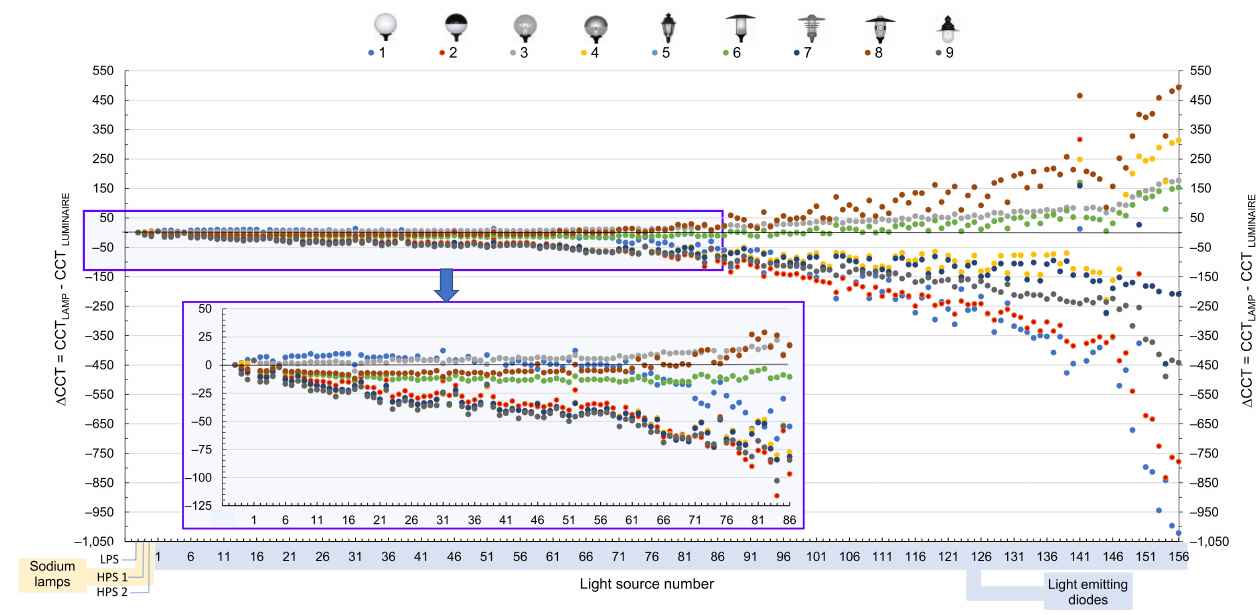
Figure 11. Graphical illustration of the CCT changes of the light sources by the luminaires.